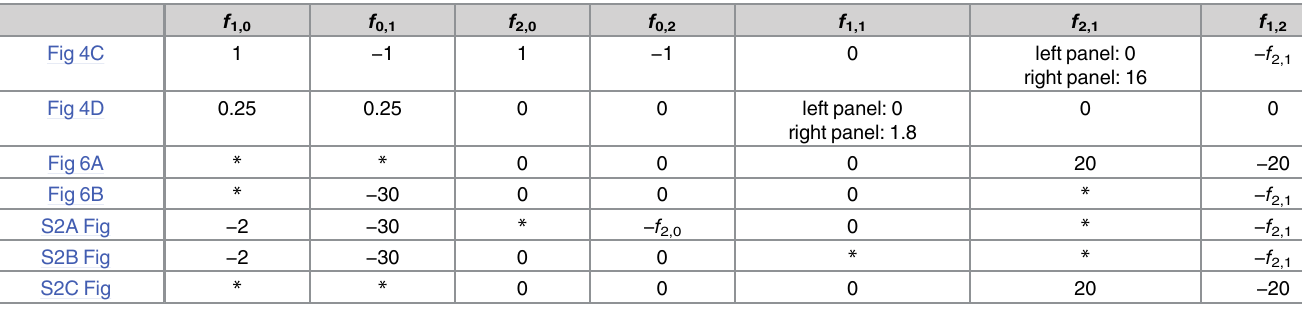
normalizes the synaptic 0